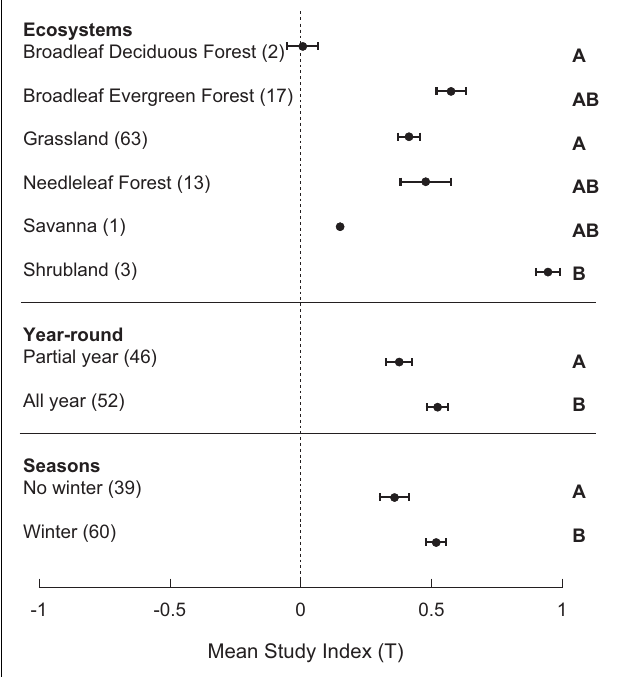
FIGURE 1 | Estimates of the study index, T , in different ecosystems and study time periods. Means are bounded by the standard error of the mean and letters denote significant differences byTukey’s HSD.